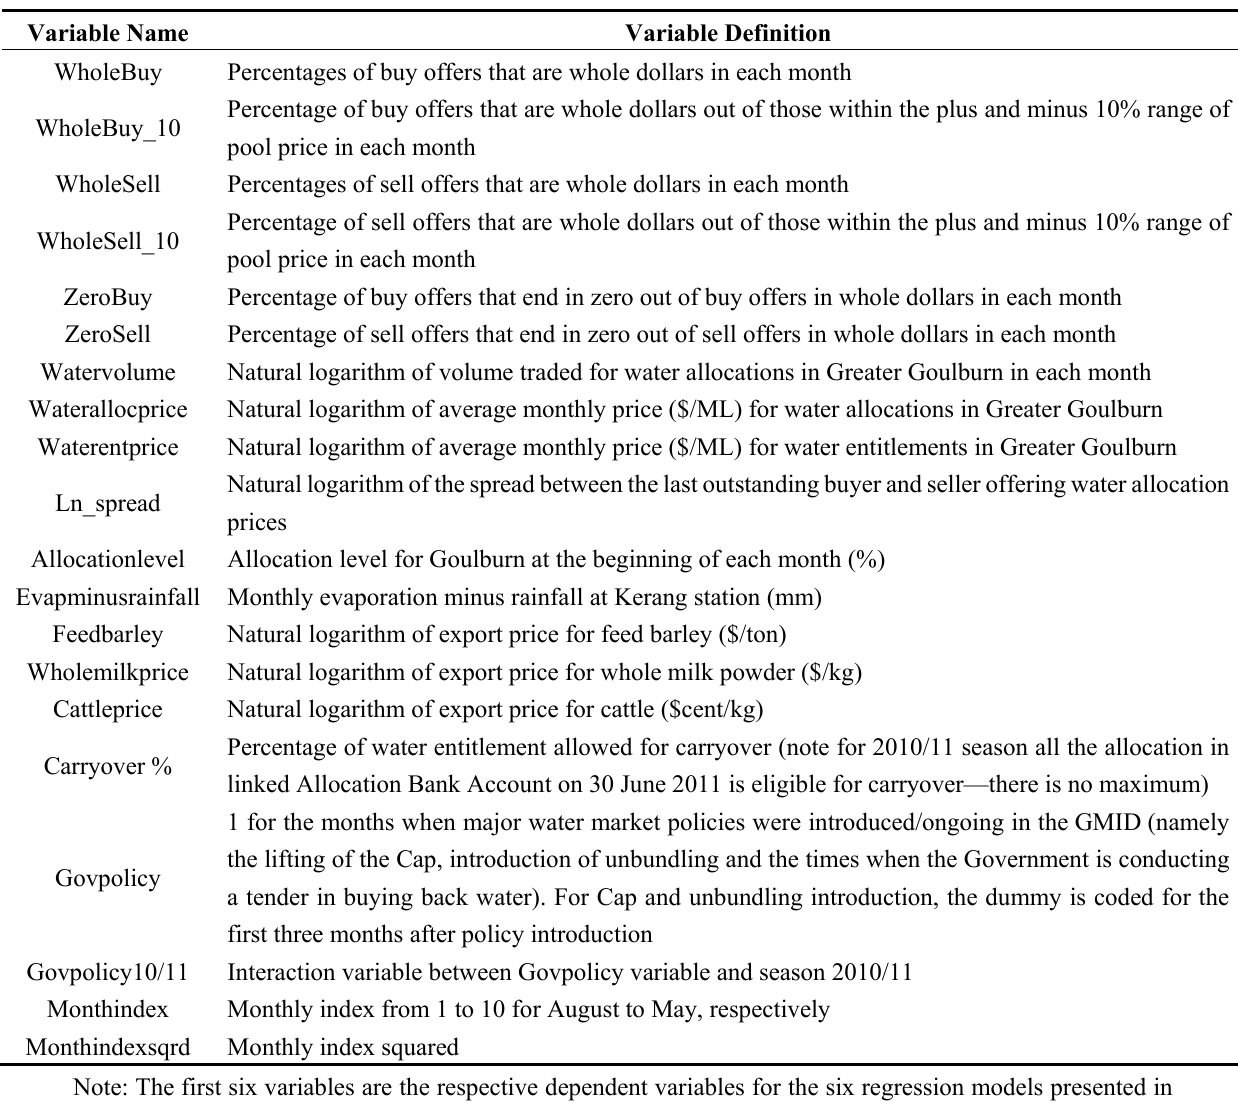
Table 4. Variable